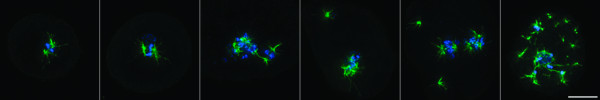
Spindle Morphologies in kif4-/380 K cells. Representative examples of normal and aberrant mitotic spindles in kif4-/380 K cultures. The two left-most panels show cells with normal appearing metaphase arrangements, with bipolar spindle MTs (in green) that flank condensed chromosomes (blue). These two figures are indistinguishable from mitotic wild type cells. The remaining four panels show examples of aberrant mitotic figures (multipolar spindles, supernumerary or fragmented spindle poles, asynchronous chromatin condensation) that are not normally found in wild-type, kif4-, or 380 K cells alone. This panel suggests that a combination of dynein and Kif4 (kinesin-7, CENP-E) activity is required for proper spindle assembly. Scale bar = 5 μm.